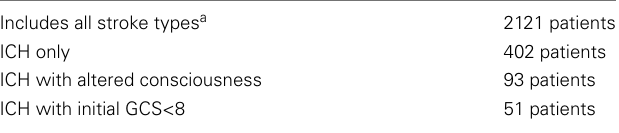
Table 1 | Flow chart of patient selection. Table 2 | Baseline characteristics for each